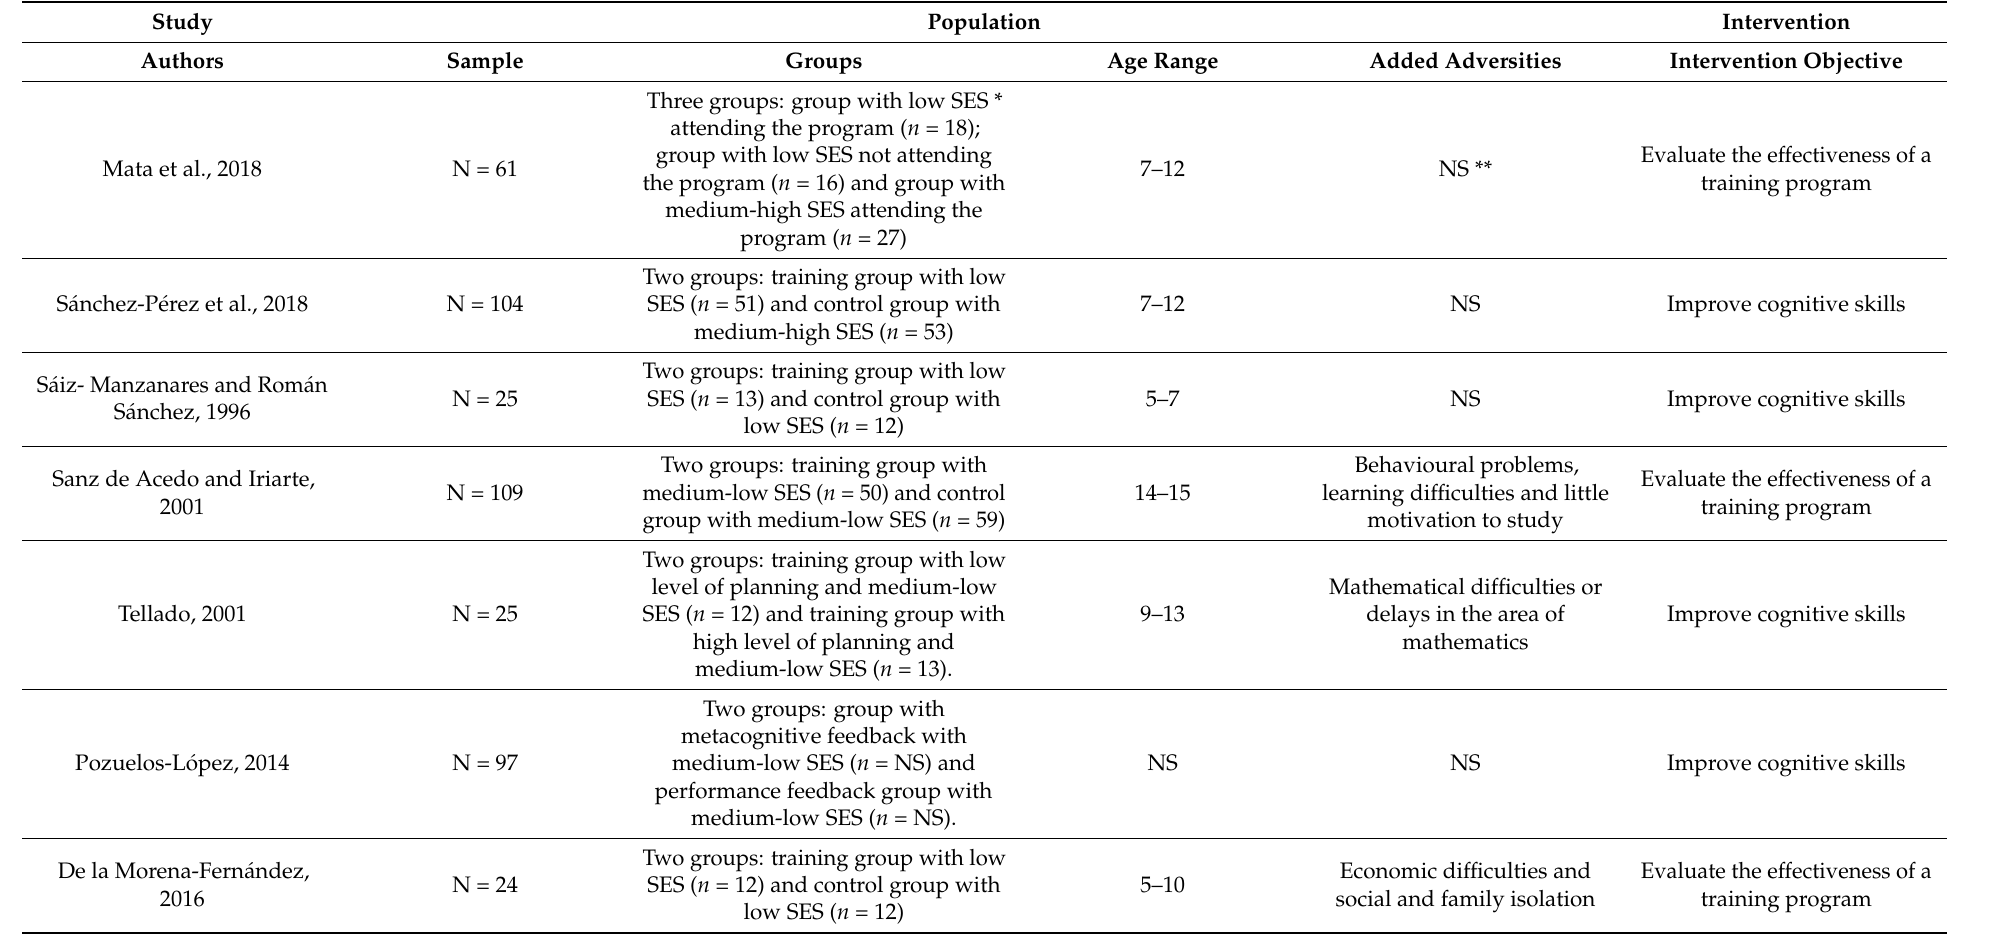
Table 2. Systematization of the studies: General